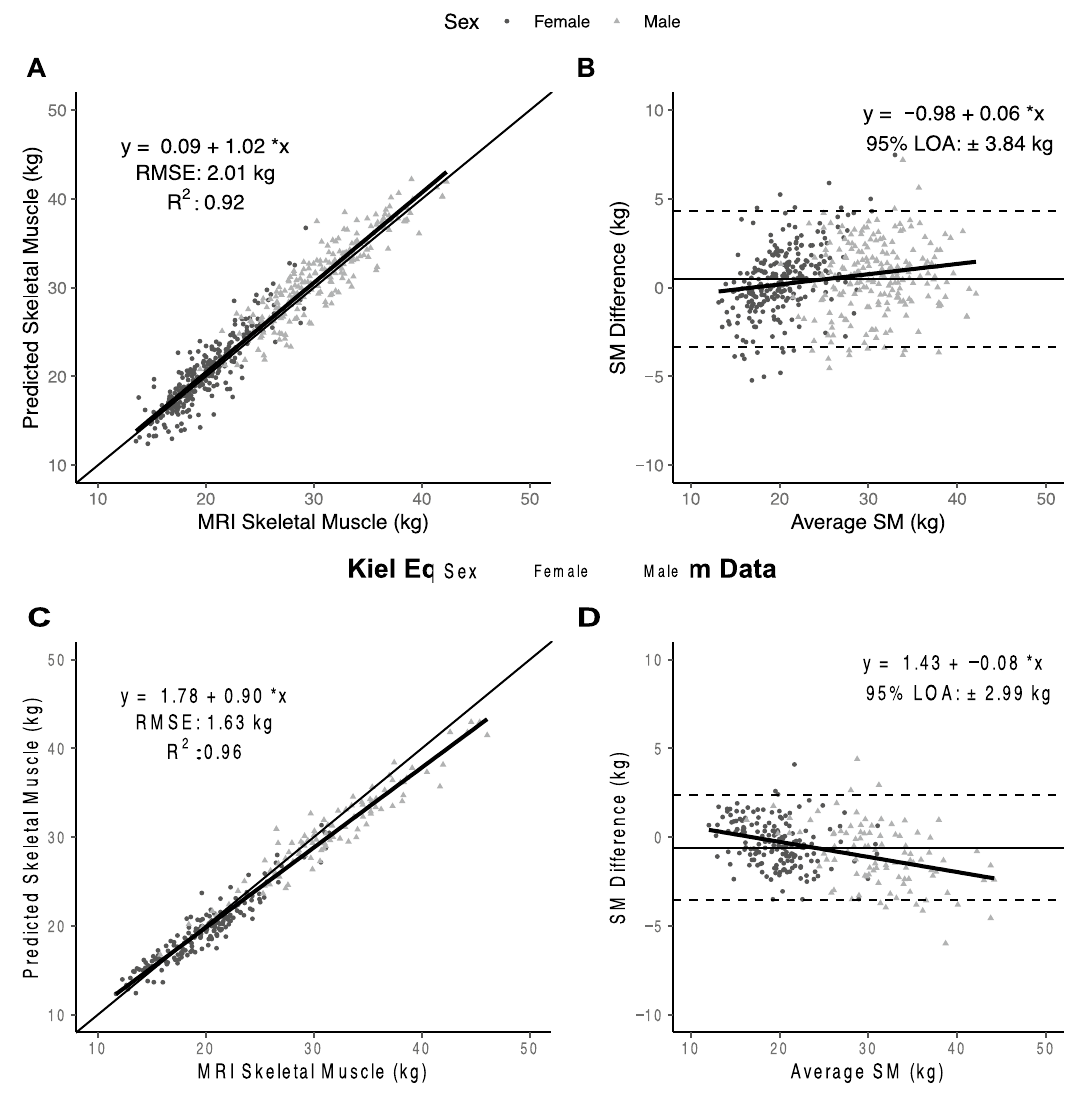
Figure 3. Total skeletal muscle (SM) mass predicted by Kim’s equation 8 versus SM measured with MRI at Kiel ( A ) and corresponding Bland–Altman plot ( B ) (n = 475). Total body skeletal muscle (SM) mass predicted by the newly developed Kiel equation versus SM measured with MRI by Kim et al. 8 ( C ) and corresponding Bland– Altman plot ( D ) (n = 270). The lines of identity (thin solid line), regression equations and lines (solid lines with gray shading indicating 95% CI), and R 2 s are shown in ( A,C ). The regression lines with 95% CI and 95% limits of agreement (LOA) (dashed lines) are shown in ( B,D ). Statistical significance of each panel is summarized in the text.